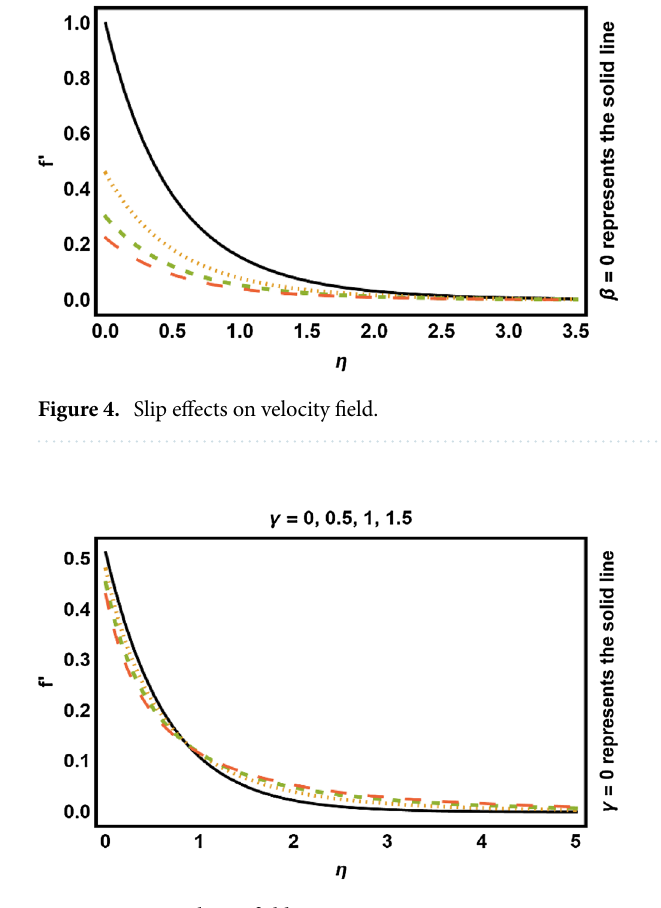
Figure 5. γ on velocity field.